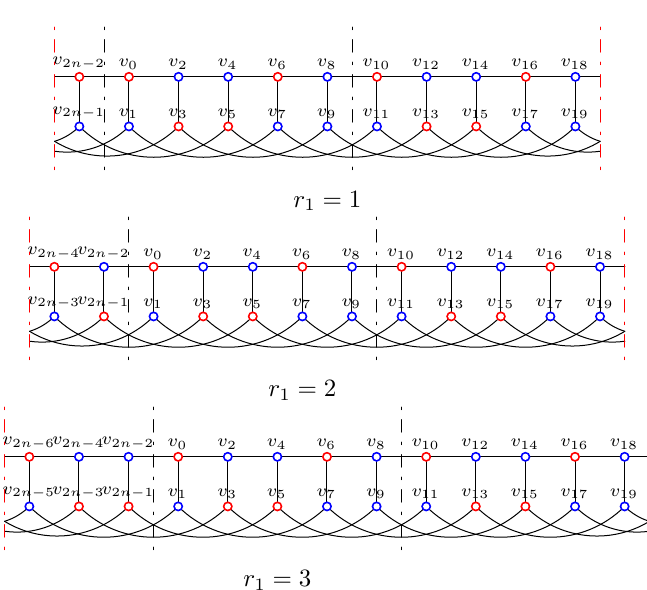
Figure 17. Segments of f in Case 1 in Lemma 10.